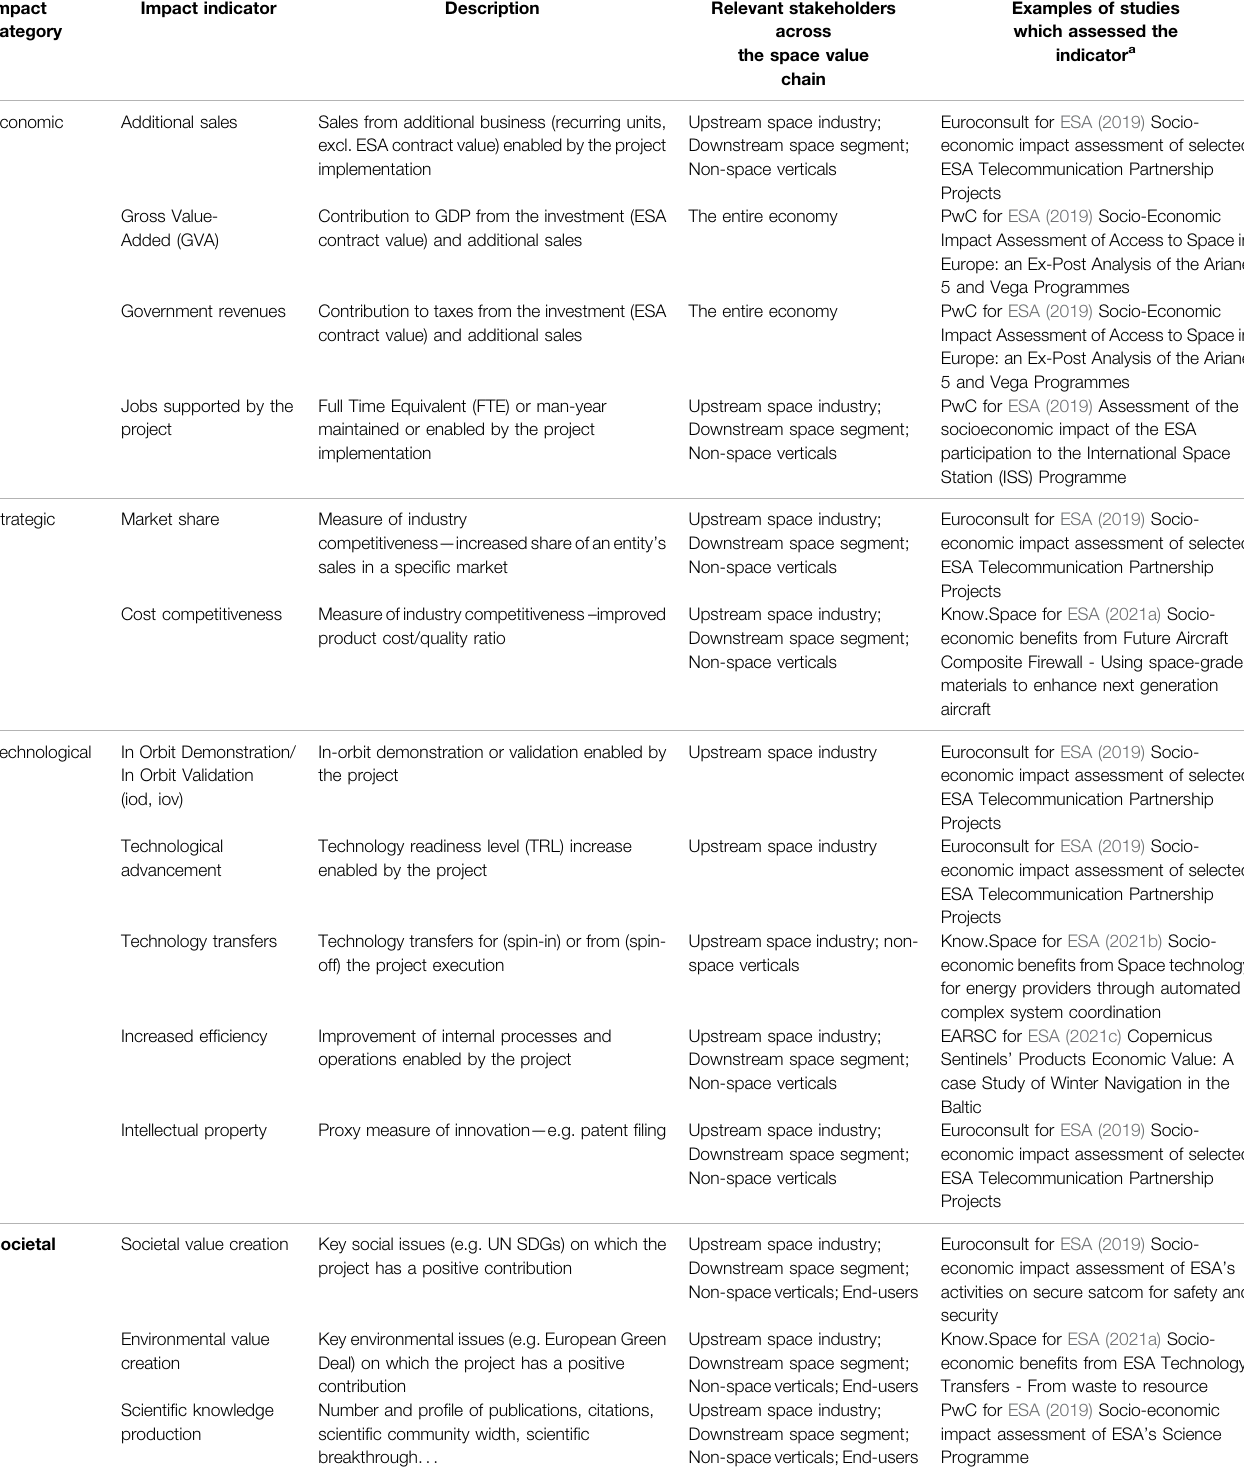
TABLE 1 | Examples of ESA ’ s socio-economic indicators used in socio-economic impact studies of ESA space